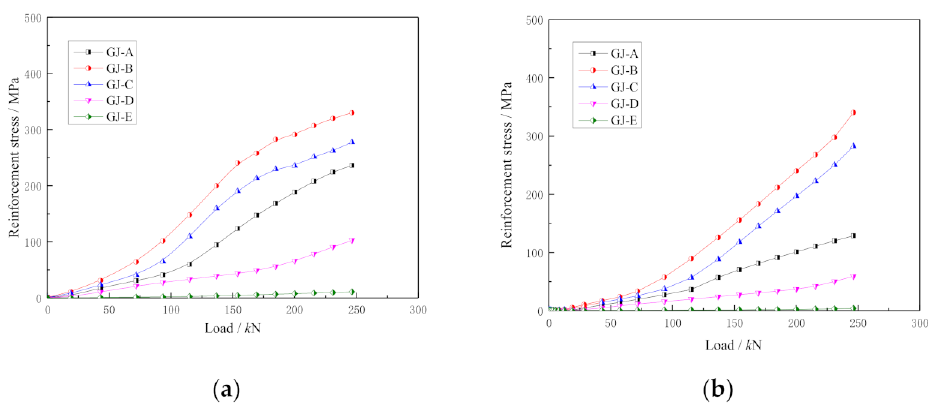
Figure 15. GD1 specimen: ( a ) No. 1 steel bar and ( b ) No. 2 steel bar.